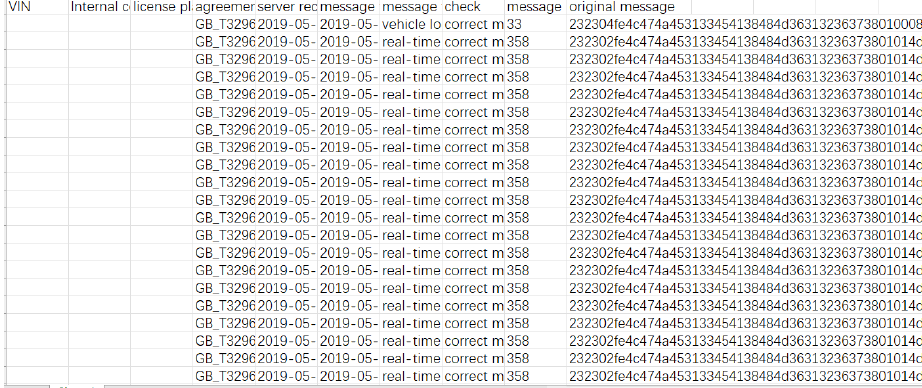
Figure 1. Power battery data format composition and original hexadecimal message.